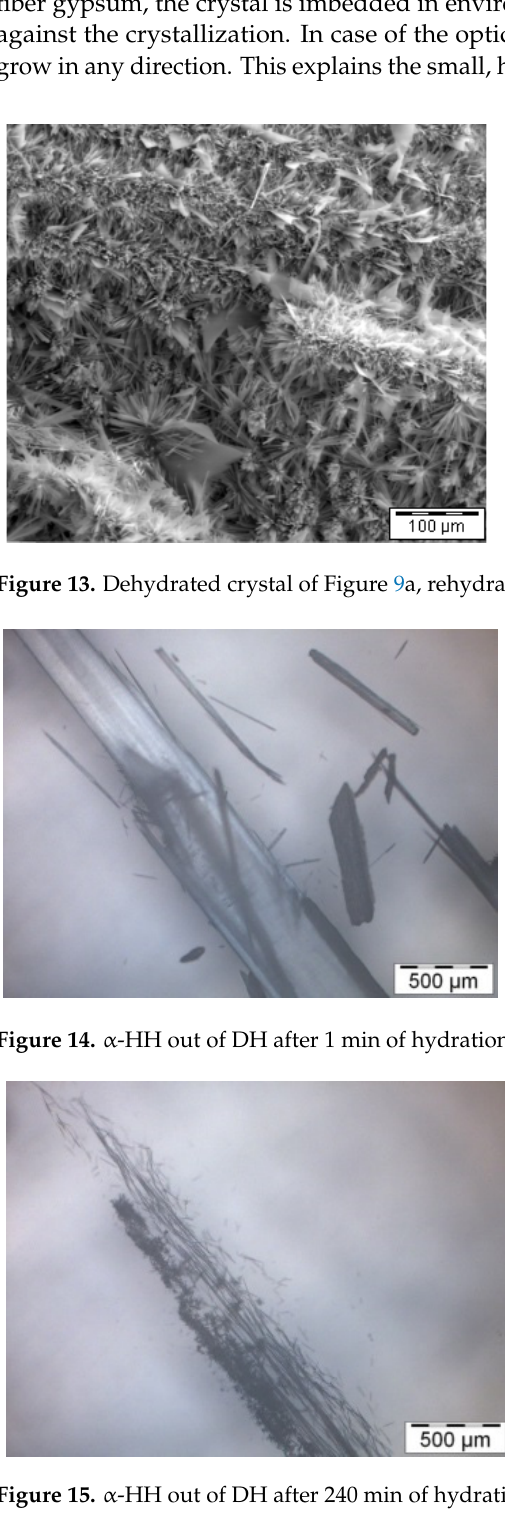
Figure 16. α -HH out of dihydrate after 240 min of hydration. The crystals which are formed inside of the gypsum crystal during dehydration were collected and measured on a zero-background holder with X-ray powder diffraction. The only phase which can be found is calcium sulfate hemihydrate, so it is obviously proven that the formed crystals are α -HH (Figure 17).